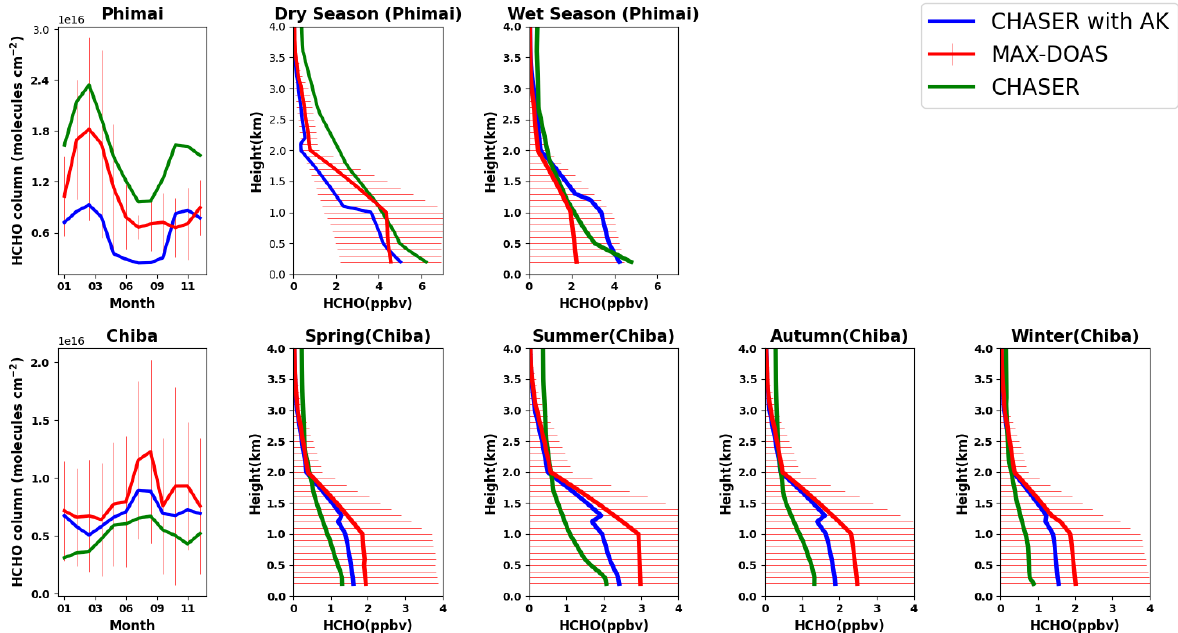
Figure 10. Seasonal variations in the HCHO partial columns at 0–4km and vertical profiles during all seasons at Phimai and Chiba, as inferred from the MAX-DOAS observations (red) and CHASER simulation (green). The CHASER HCHO partial column and vertical profile smoothed with the MAX-DOAS AK are colored blue. The AK information of all the screened (as explained in Sect. 2.2) retrievals was averaged based on the seasonal classification of the respective sites. Only the coincident time and date between the model and observations are selected. Error bars indicate the 1 σ standard deviation of mean values of the MAX-DOAS observations. Table 6. Comparison of the seasonal mean HCHO partial columns and profiles (0–4km) between MAX-DOAS and CHASER at Phimai and Chiba. MBE (CHASER − MAX-DOAS) is the mean bias error. The partial-column and profile MBE units are × 10 16 moleculescm − 2 and parts per billion by volume (ppbv), respectively. Site Season Partial-column Smoothed-partial- Profile Smoothed- MBE column MBE MBE profile